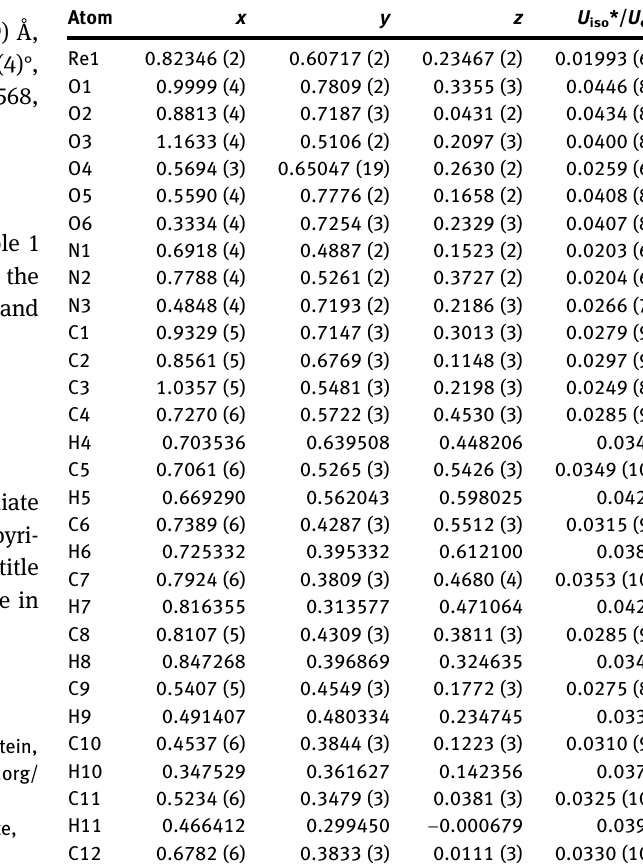
Table  : Fractional atomic coordinates and isotropic or equivalent isotropic displacement parameters (Å 